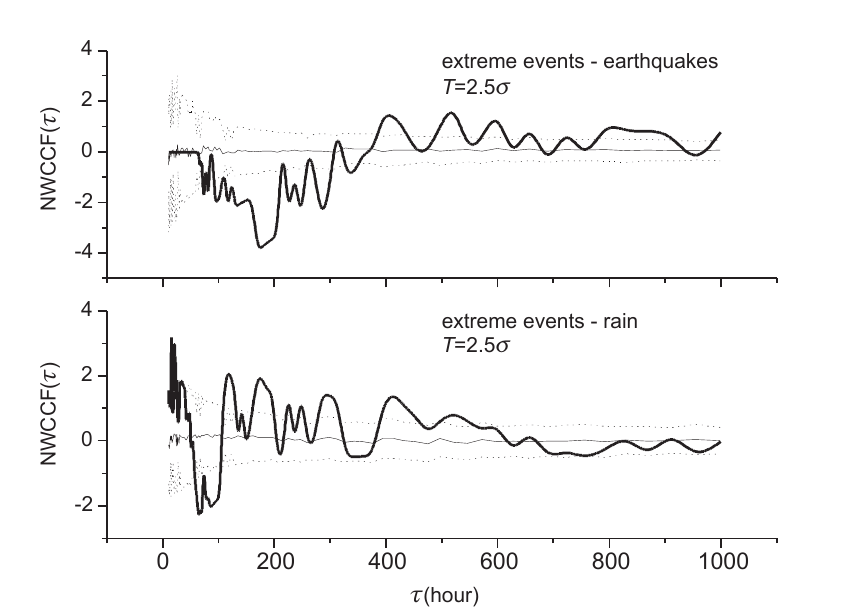
Fig. 5. NWCCF( τ ) ∼ τ relation for EE-EQ and EE-RR pairs, with T = 2.5 σ .